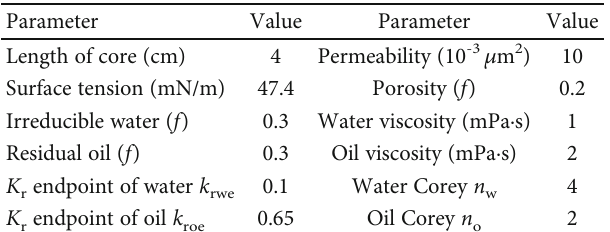
Table 1: Typical low permeability core properties and fl uid